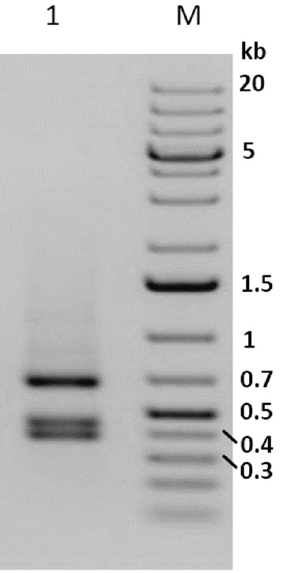
Figure 1. Agarose gel (1%) electrophoresis of the AluI digest of the egt PCR product from purified DNA of collected single larvae from the insect population Phop-IT (lane 1). Size marker (lane M) 1 kb plus ladder. A negative image of the stained gel is shown for better visualization of the PCR fragments.